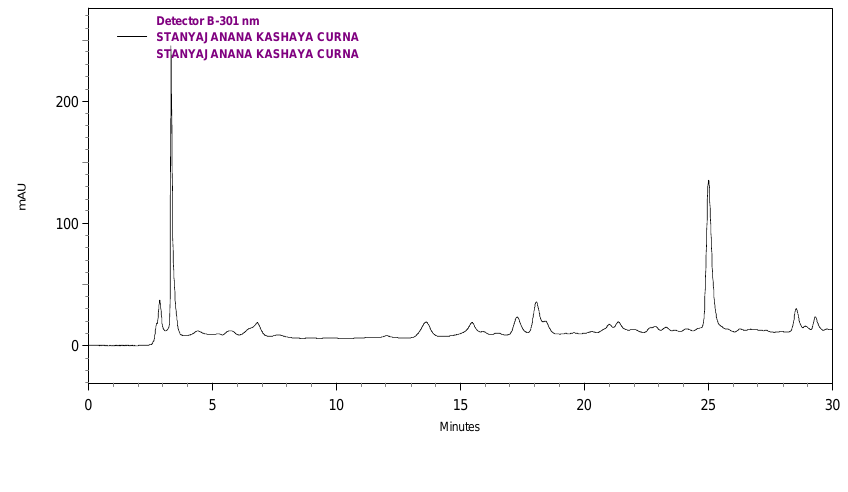
Figure 3. HPLC Chromatogram of Stanyajanana Kashaya